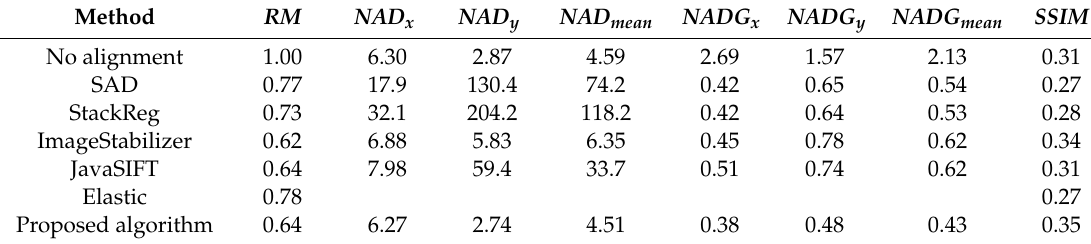
Table 4. Alignment metrics for image